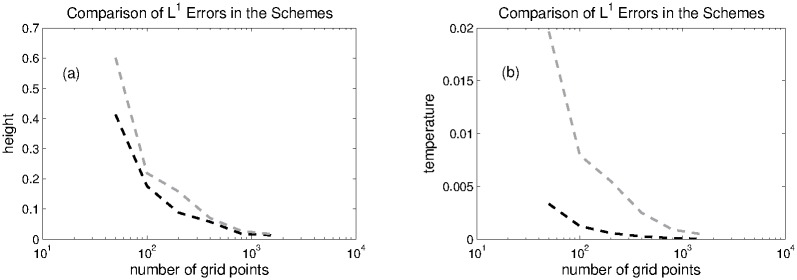
Problem 1: A comparison of L1 errors in the height and temperature of both schemes at different grid points.